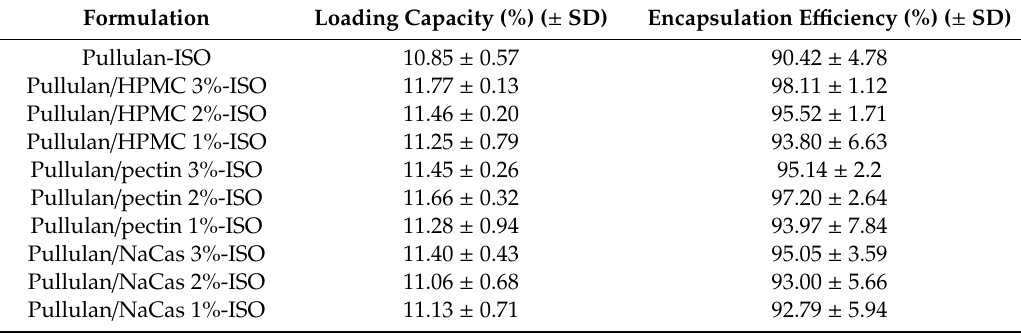
Table 2. Drug loading capacity and encapsulation efficiency of the ISO-loaded develop orodispersible films (ODFs).